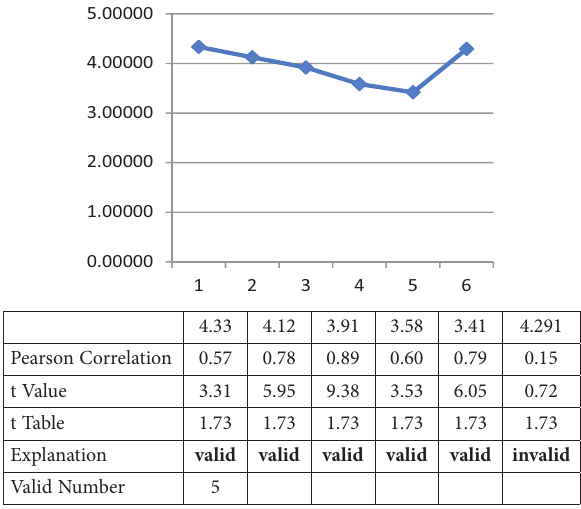
Table 6. Degree of change in the residents’ prosperity